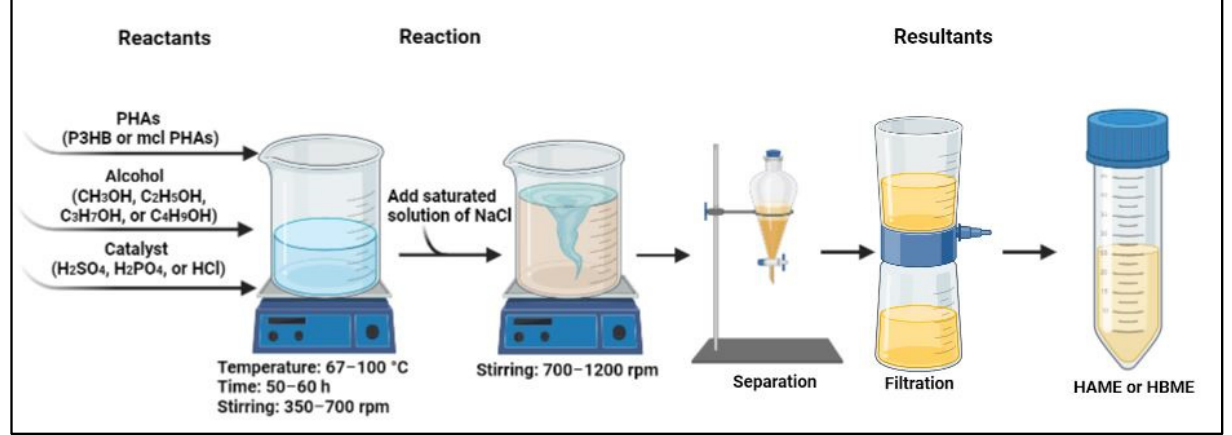
Figure 3. Schematic production of polymeric biodiesel HAME and HBME. Table 2. Optimum values for polymeric biodiesel production HAME and